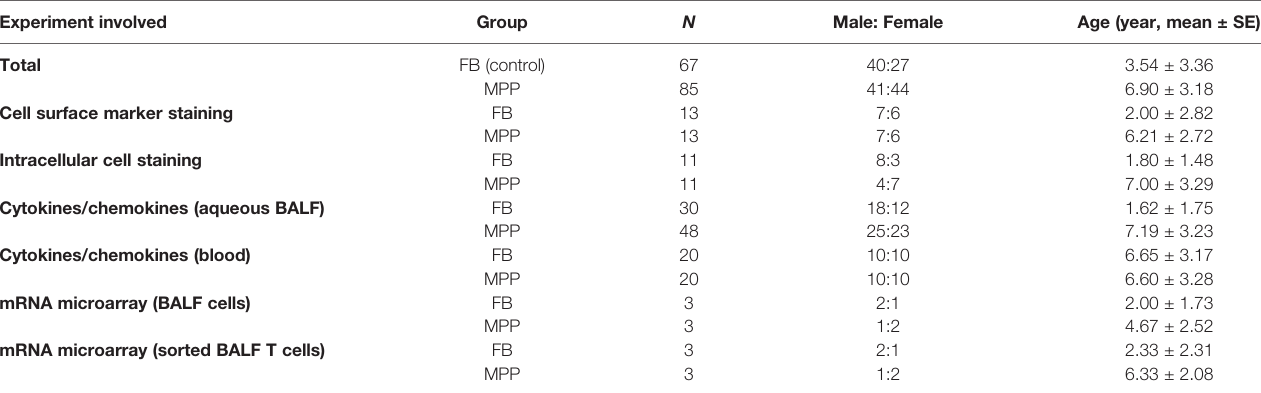
TABLE 1 | Patient Information and each experiment involved. Experiment